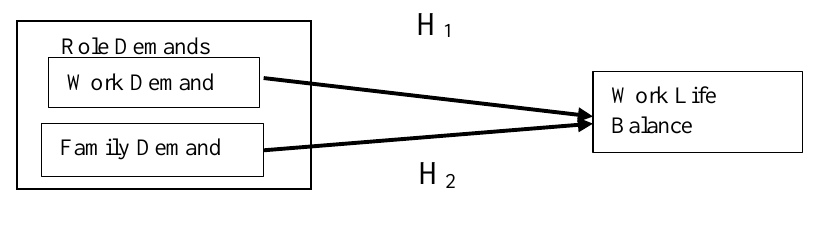
Figure 1: Conceptual Framework for the